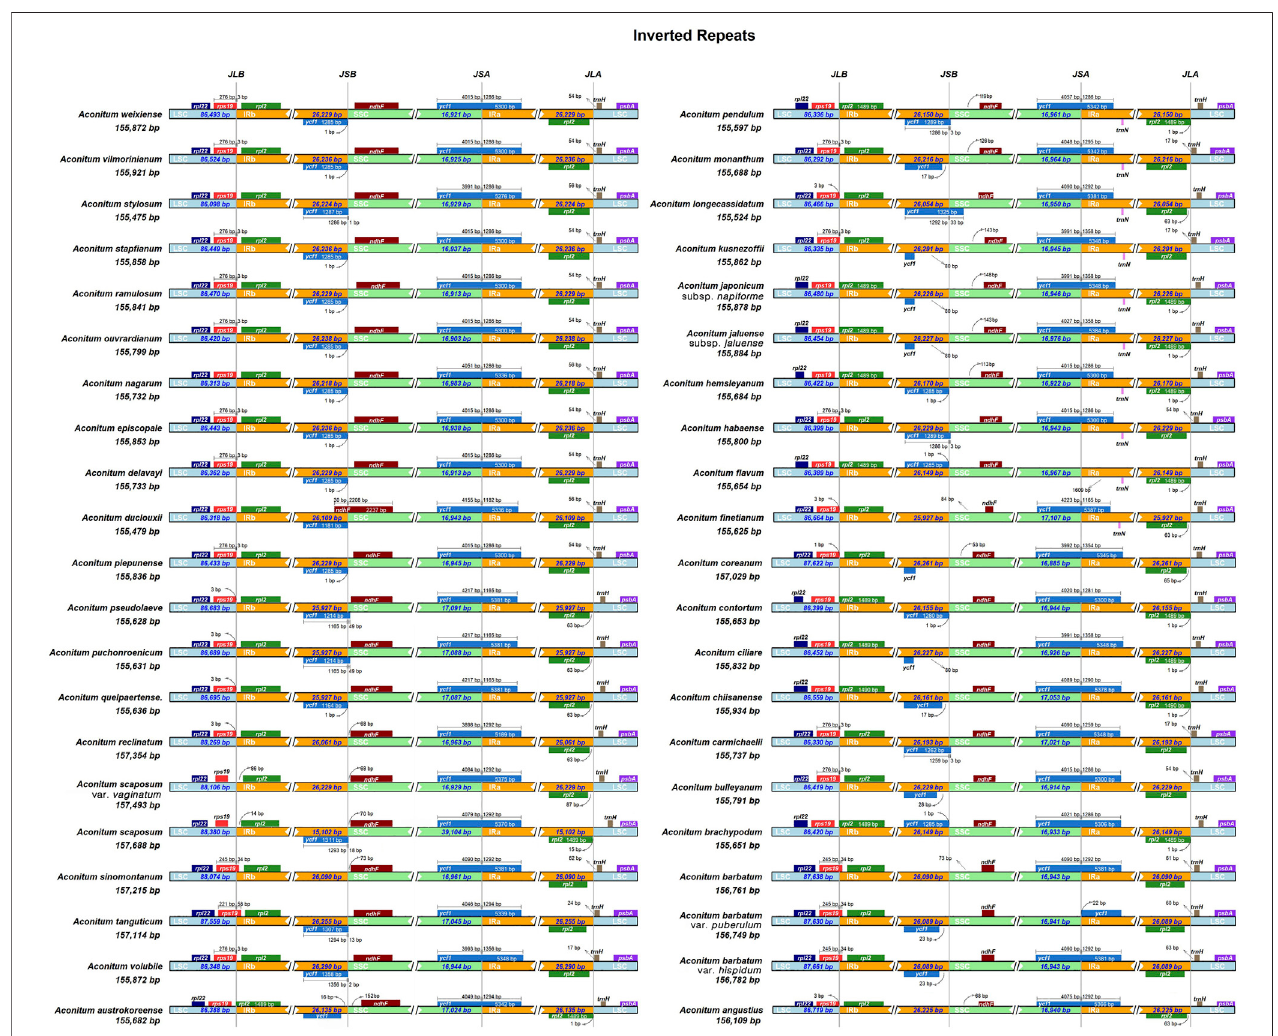
FIGURE 8 | Comparison of LSC, SSC, and IR region borders among CP genomes of 42 Aconitum species.